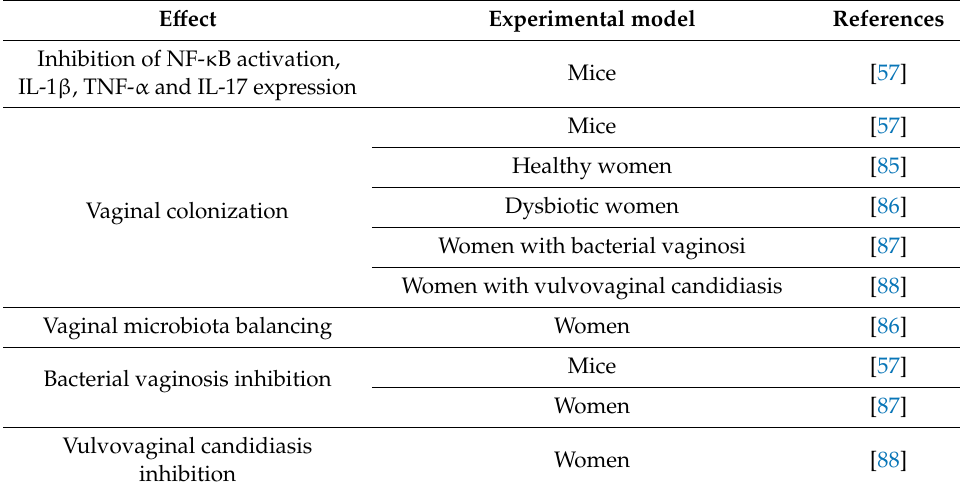
Table 4. E ff ects of lactoferrin and lactobacilli combination: Preclinical and clinical